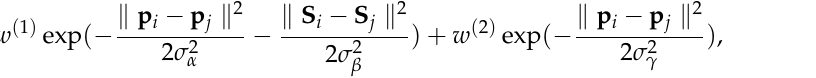
Figure 8. Flowchart of the FCCRF-based refinement. The class probabilities and the feature importance indicators generated by the trained RFE model are used to construct the unary potential and the pairwise potential, respectively.